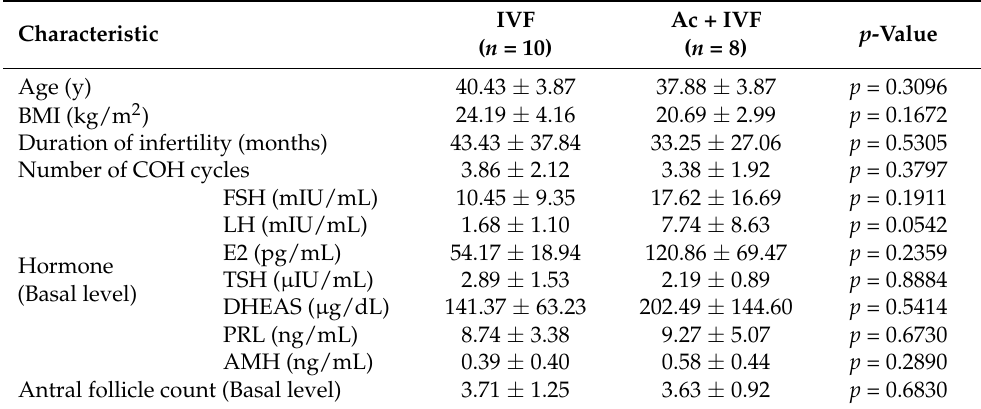
Table 7. Clinical characteristics of patients enrolled in the two study groups undergoing more than